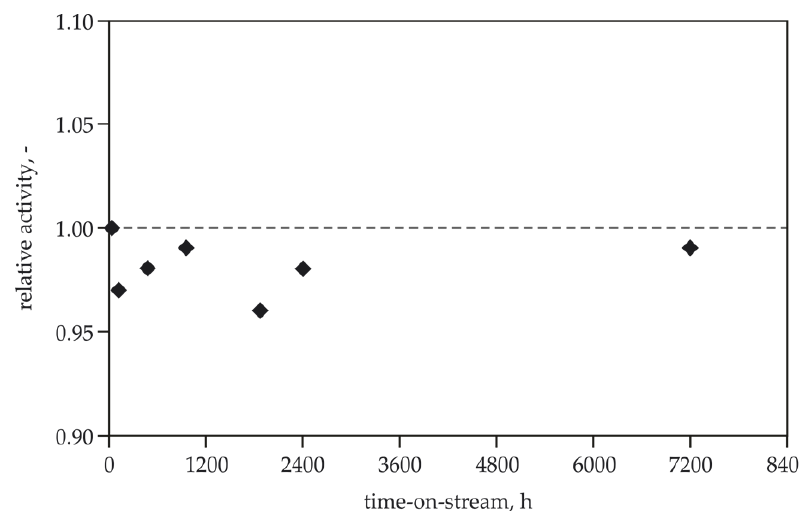
Figure 5. Long-term stability test of K/Zn 0.4 Co 2.6 O 4 / α -Al 2 O 3 catalyst. Test parameters: T NG = 445 °C, p = 10.5 bar, V NG = 40 Nm 3 /h.